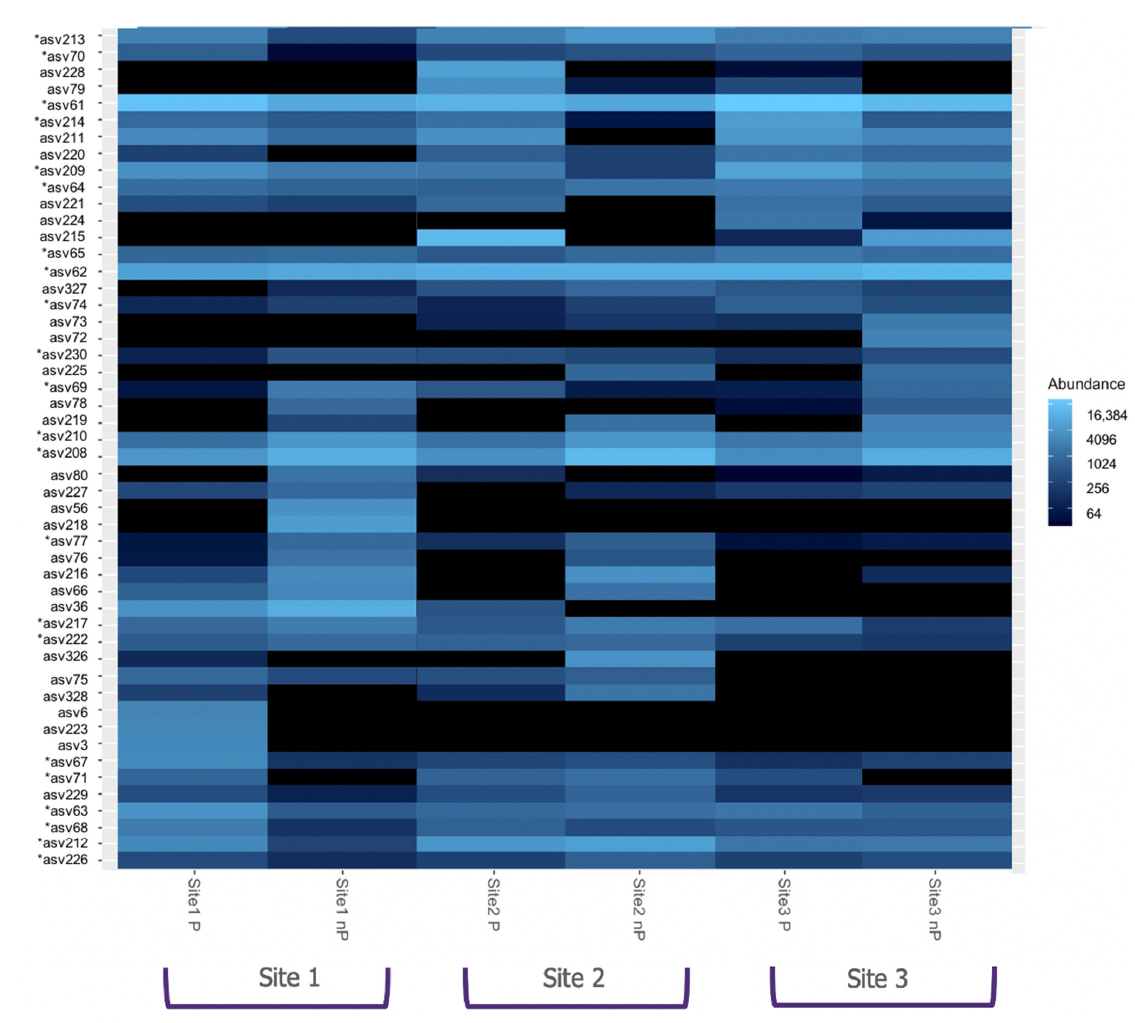
Figure 5. Heatmap representation showing the abundance of the 50 most abundant ASVs across all the sampling sites. The 50 most abundant ASVs include the 26 core ASVs shared by the six sampling sites *: Core ASVs shared by all sampling sites.